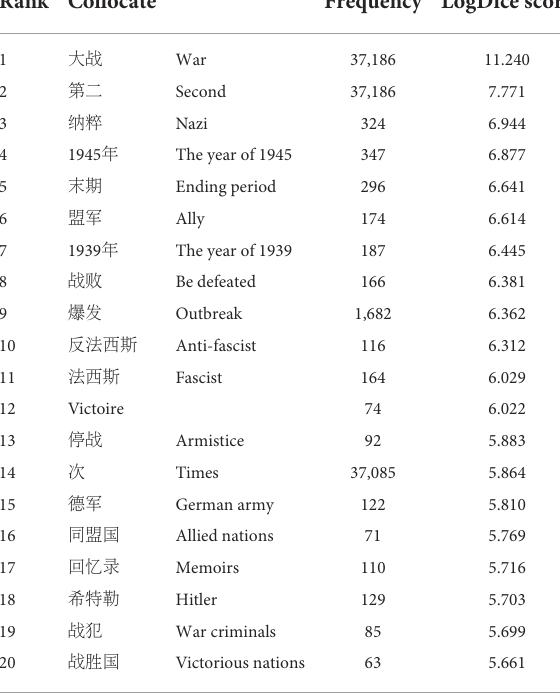
TABLE 8 The collocates of 第 二 次 世 界 大 战 di4er4ci4shi4jie4da4zhan4 (the second world war) within a four-word span. Rank Collocate Frequency LogDice score